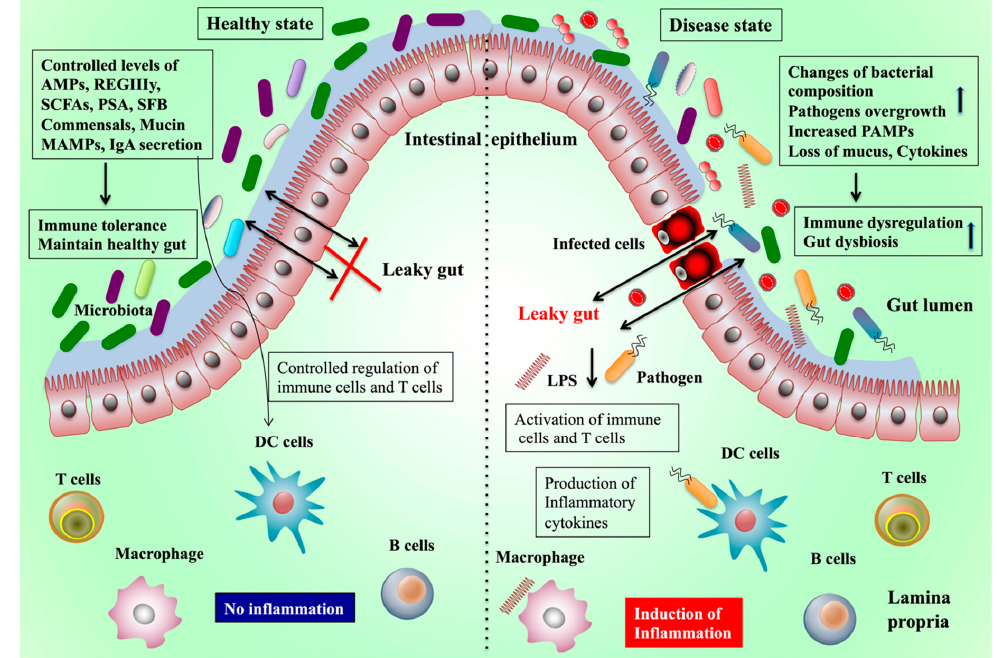
Figure 1. Host–gut microbiota interaction on the maintenance of a healthy gut and the induction of inflammation. The gut microbiota and its cellular components and metabolites induce immune cells, goblet, and paneth cells to produce functionally active components, immunoglobulin, and anti-inflammatory cytokines to maintain gut homeostasis and a healthy gut, with no leaky gut or inflammation. On the other hand, antibiotics, inflammatory bowel diseases (IBD), obesity, dietary modification, and other environmental factors induce gut dysbiosis, which increases the loss of gut hemostasis, impaired gut barrier integrity, and bacterial overgrowth. The disruption of the gut barrier integrity increases the permeability of pathogens and pathogen-associated molecular patterns (PAMPs) from the gut lumen to the lamina propria, where they interact with the respective toll-like receptors (TLRs) and other receptors on immune cells to dysregulate the host immunity and induce intestinal